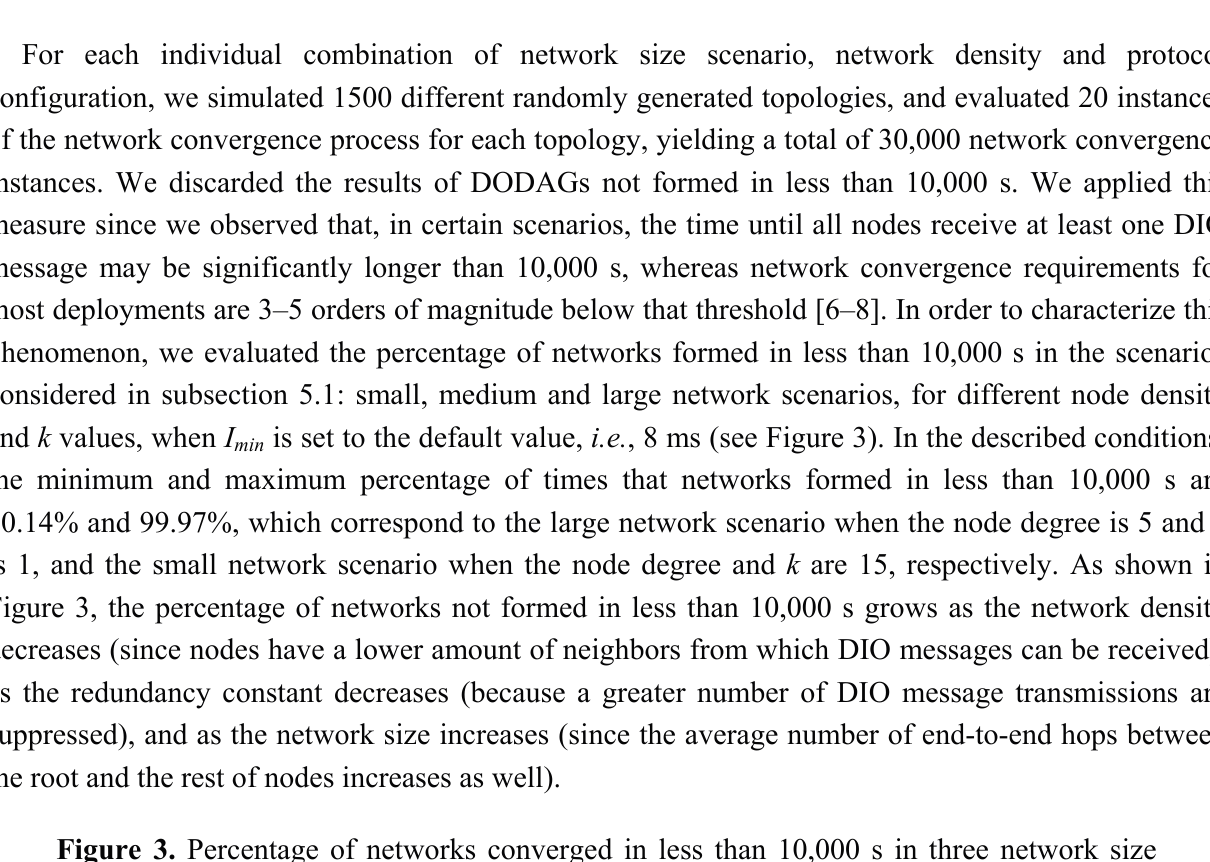
Figure 3. Percentage of networks converged in less than 10,000 s in three network size scenarios, for different node densities, as a function of the redundancy constant, k : ( a ) Small network scenario, ( b ) medium network scenario, and ( c ) large network scenario,